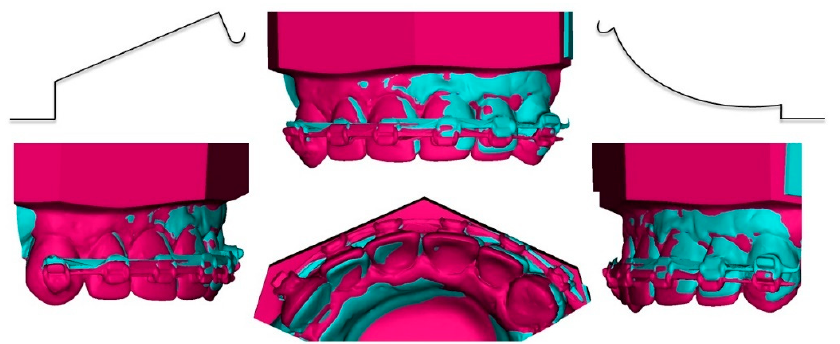
Figure 12. Asymmetric cantilever activation: activation of utility arch (right side of typodont) and deep curve cantilever (left side of typodont), resulting intrusion and displacement of anterior segment (before: pink; after: blue).